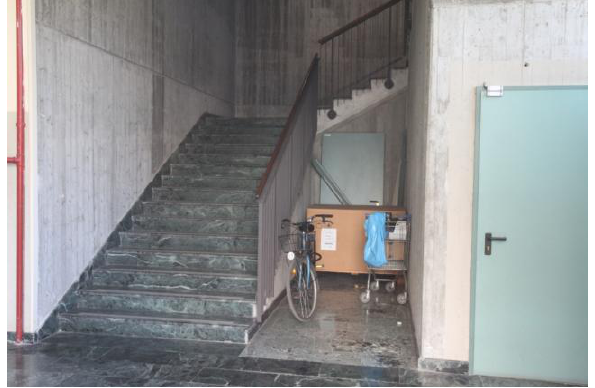
Figure 2. The building’s